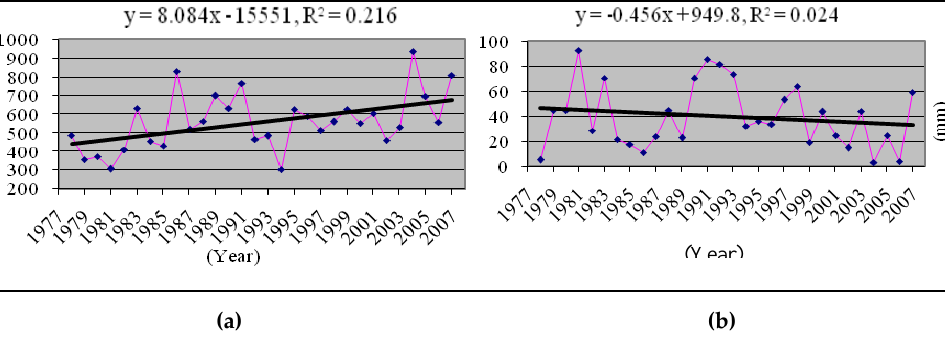
Figure 9. Total rainfall in Bangladesh ( a ) Post-Monsoon and ( b ) Winter.